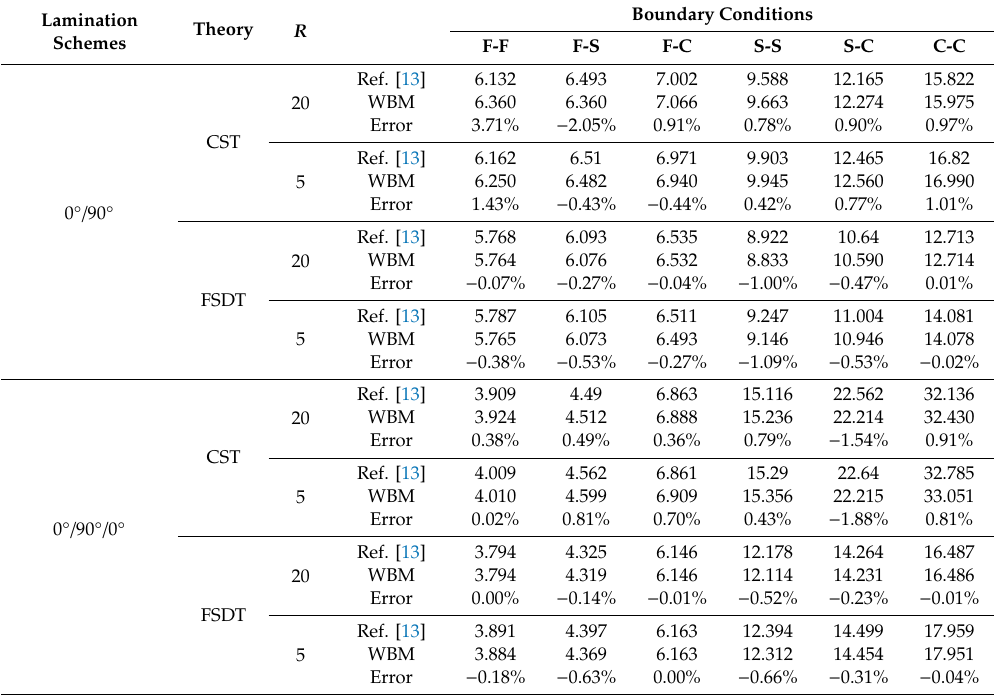
Table 6. The fundamental frequency parameter Ω for two types of the layered composite shallow spherical shell with various boundary conditions, theories, and